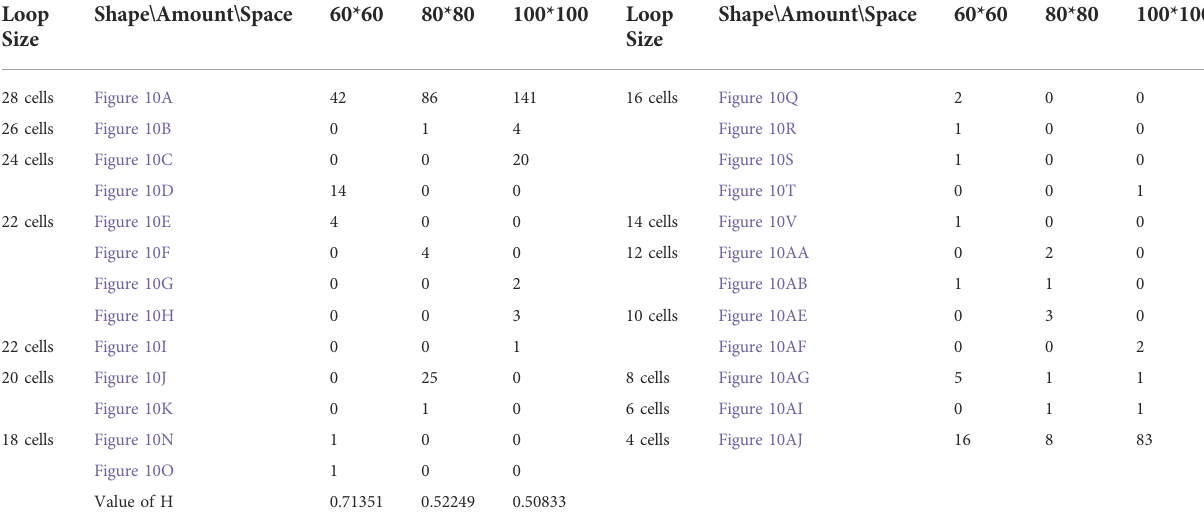
TABLE 9 Statistical numbers of the loops with various structures for the adding mechanism on different cellular spaces starting from the initial con fi guration in Figure 7C. Loop Shape ∖ Amount ∖ Space Size